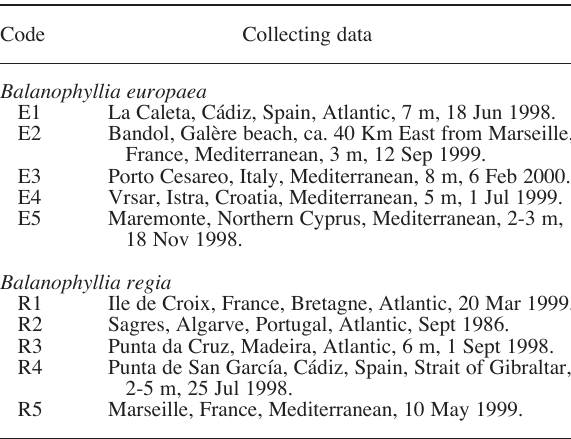
T ABLE 1. – List of sampling stations and collecting data, see also Figure